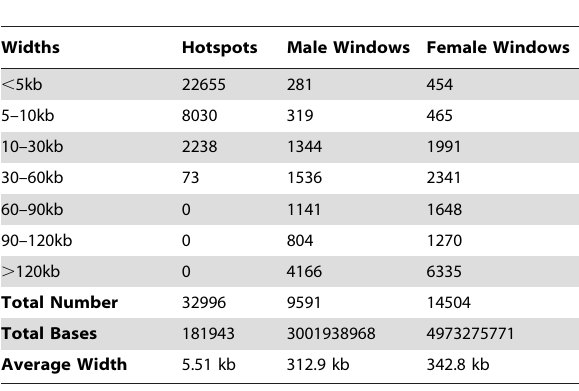
Table 1. Sizes of recombination mapping